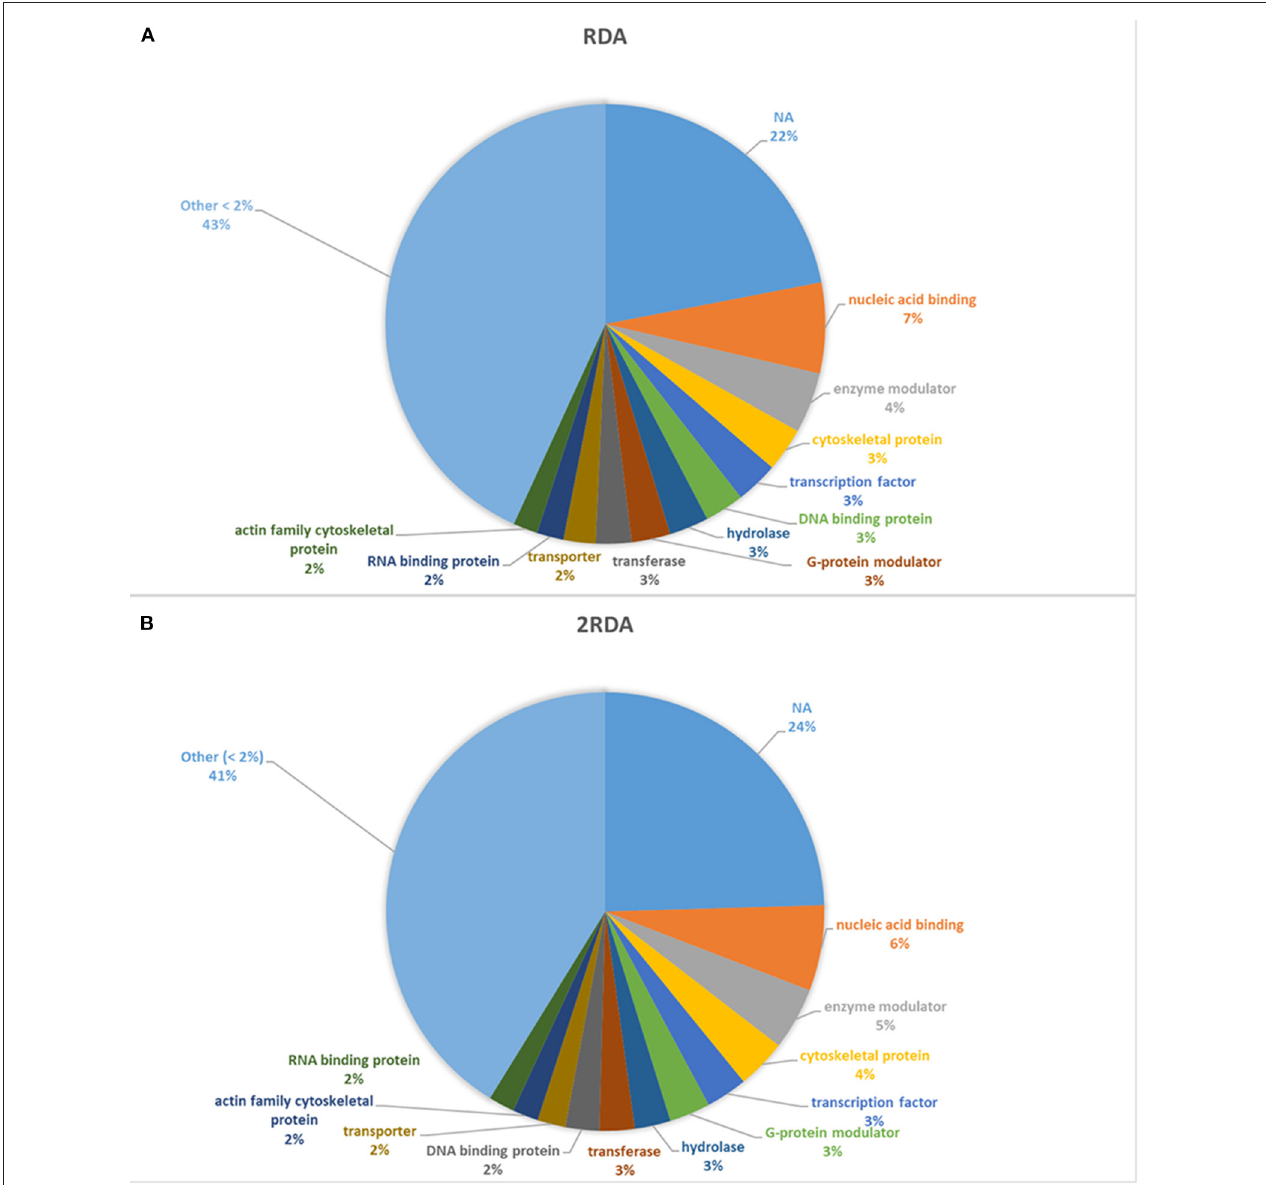
FIGURE 3 | Distribution of protein classes present > 2% of reads. NA refers to unassigned proteins. (A) includes the 9 participants on the RDA diet and (B) refers to the results from the 10 participants in the 2RDA